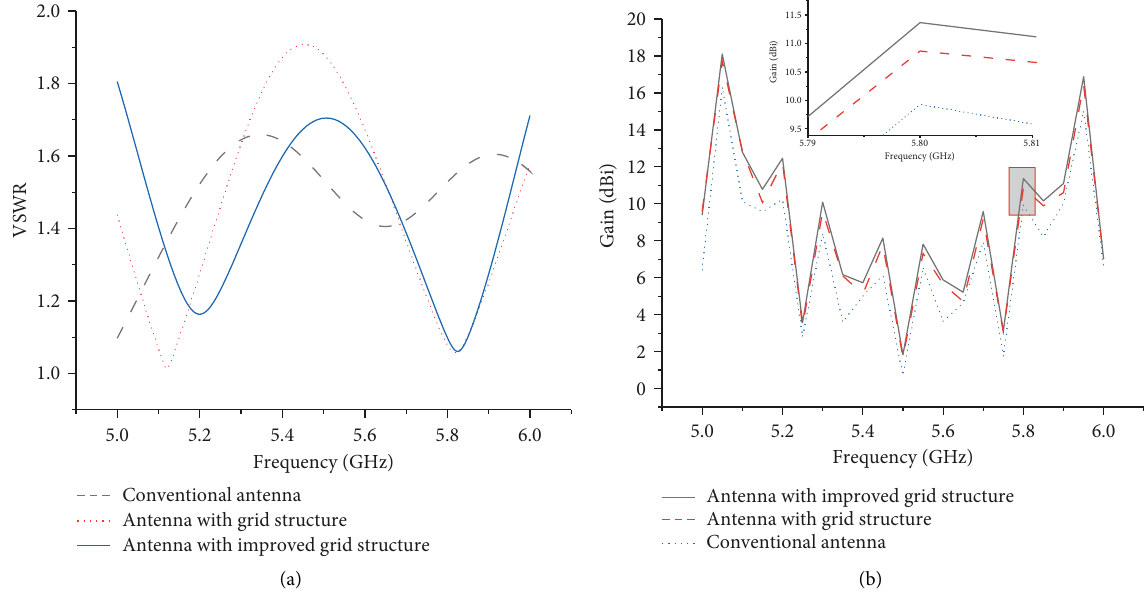
Figure 4: Performance parameters: (a) voltage standing-wave ratio; (b) gain of